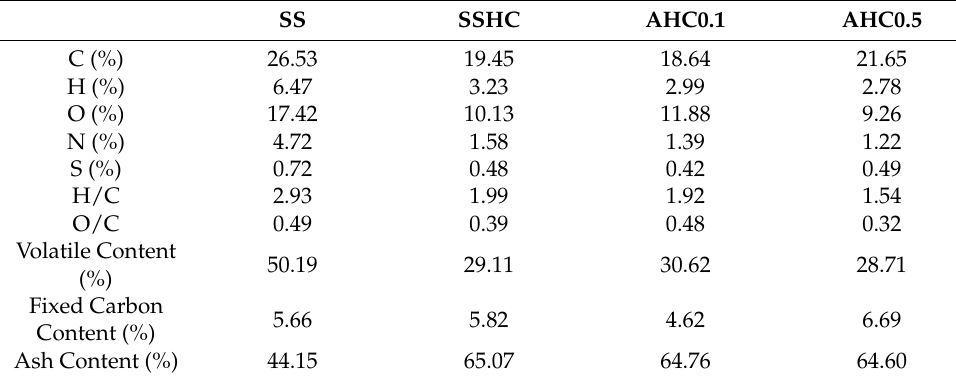
Table 1. Ultimate analysis and proximate analysis of SS and SS-derived